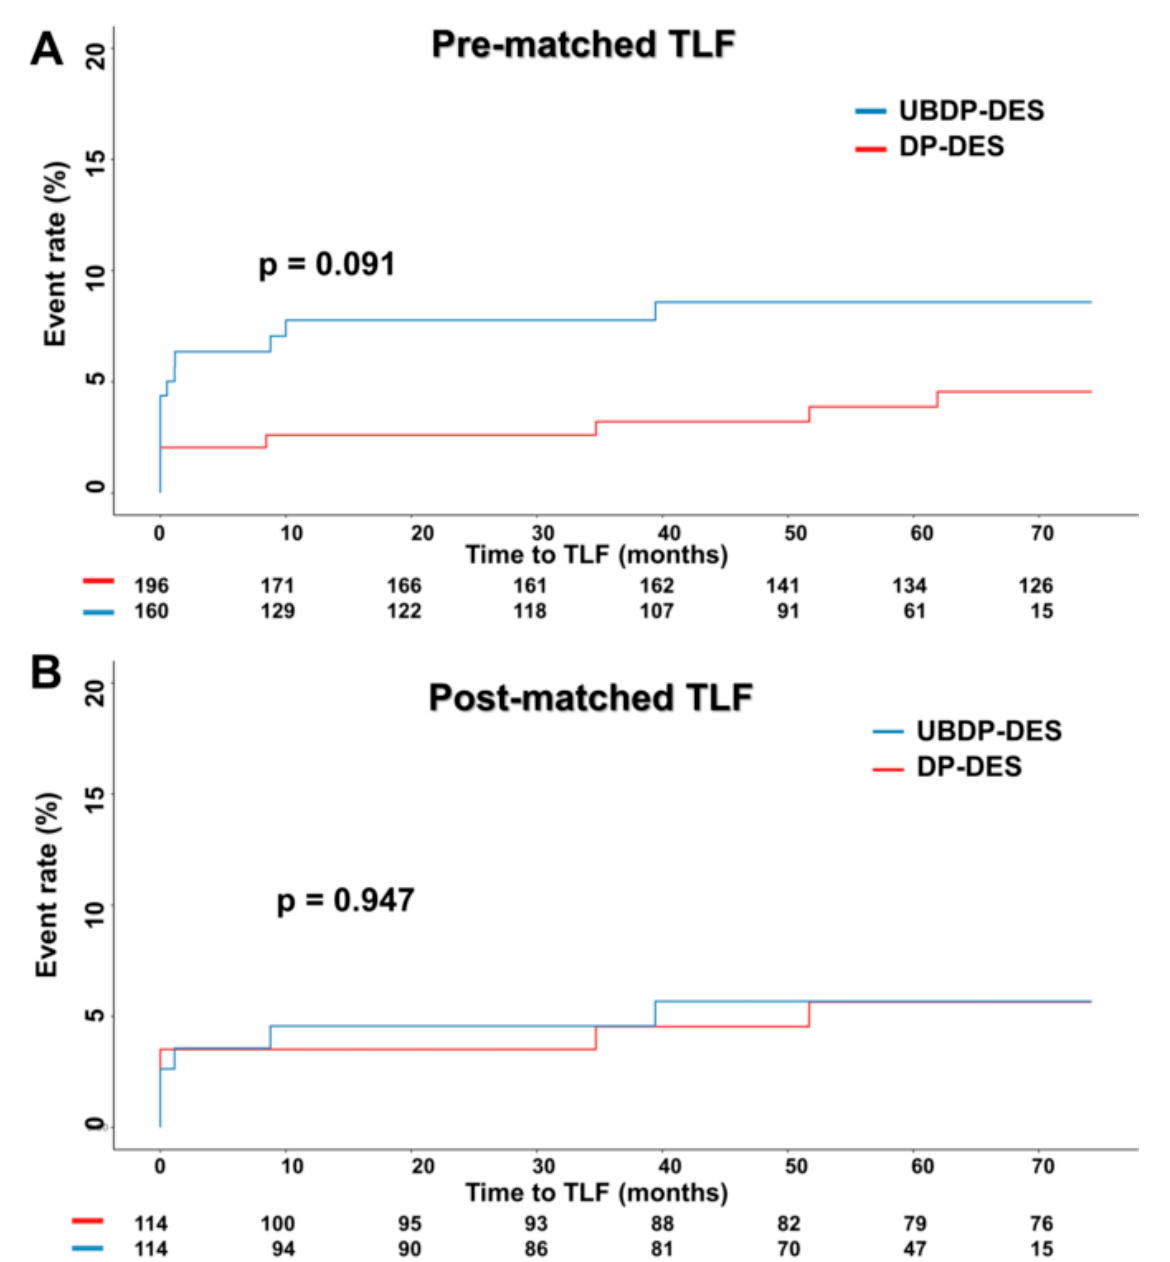
Figure 2. Kaplan–Meier survival curves of TLF ( A ) pre- and ( B ) post-PSM. All abbreviations are listed in Table 1.